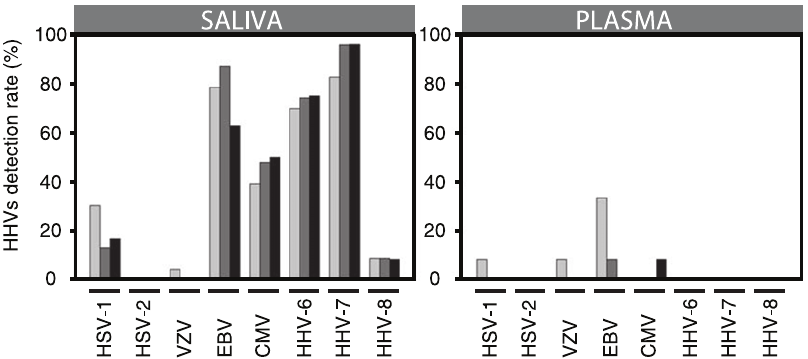
Figure 1. Prevalence of HHVs in saliva and plasma. Detection rate of HHVs in saliva samples and plasma samples from children with acute malaria before (M + day-0; light gray bars) and after (M + day-14; dark gray bars) anti-malarial treatment and in children having mild infections unrelated to malaria (M 2 ; black bars). All samples were considered for this analysis, regardless the serological status of the patients for a select HHV.